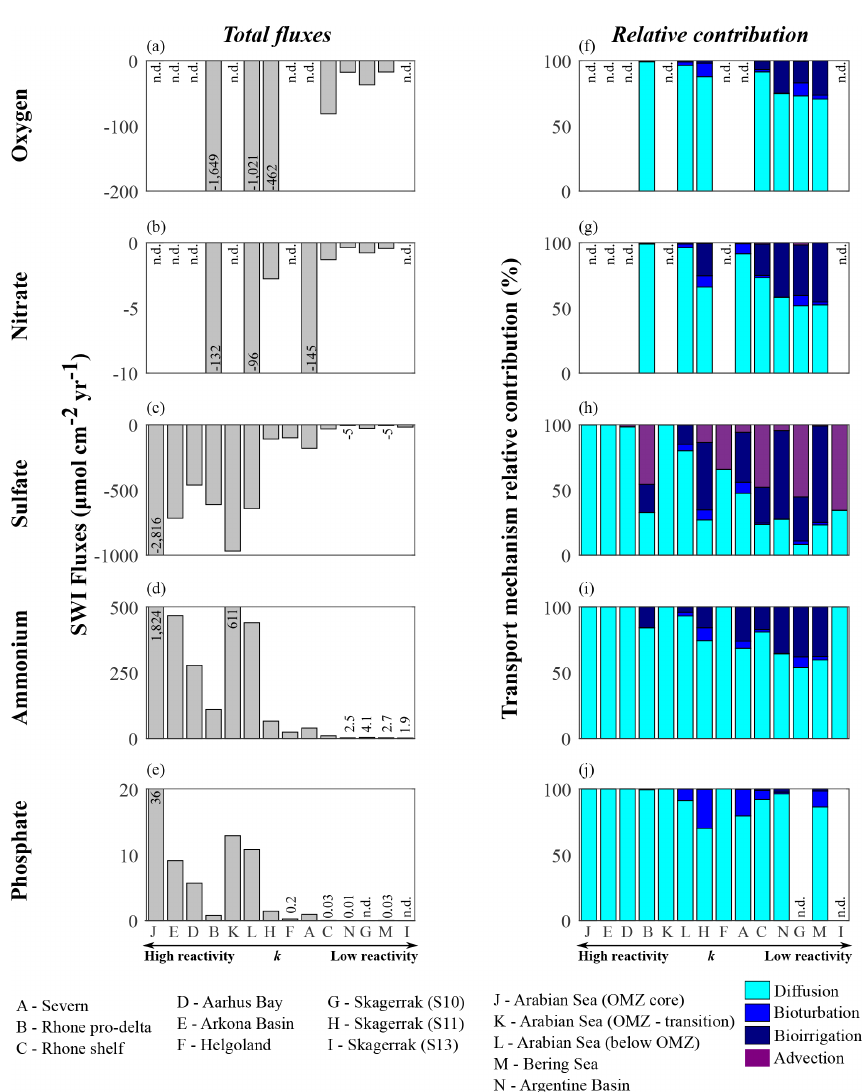
Figure 9. Benthic fluxes of dissolved species (a–e) and transport mechanism relative contributions (f–j) : (a, f) oxygen, (b, g) nitrate, (c, h) sulfate, (d, i) ammonium, and (e, j)